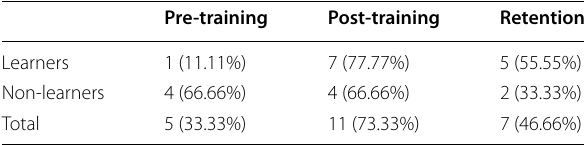
Table 5 Number of participants performing at above‑chance levels (real AUC > 95 th % simulated AUC) at each testing phase, split‑up for learners, non‑learners, and total